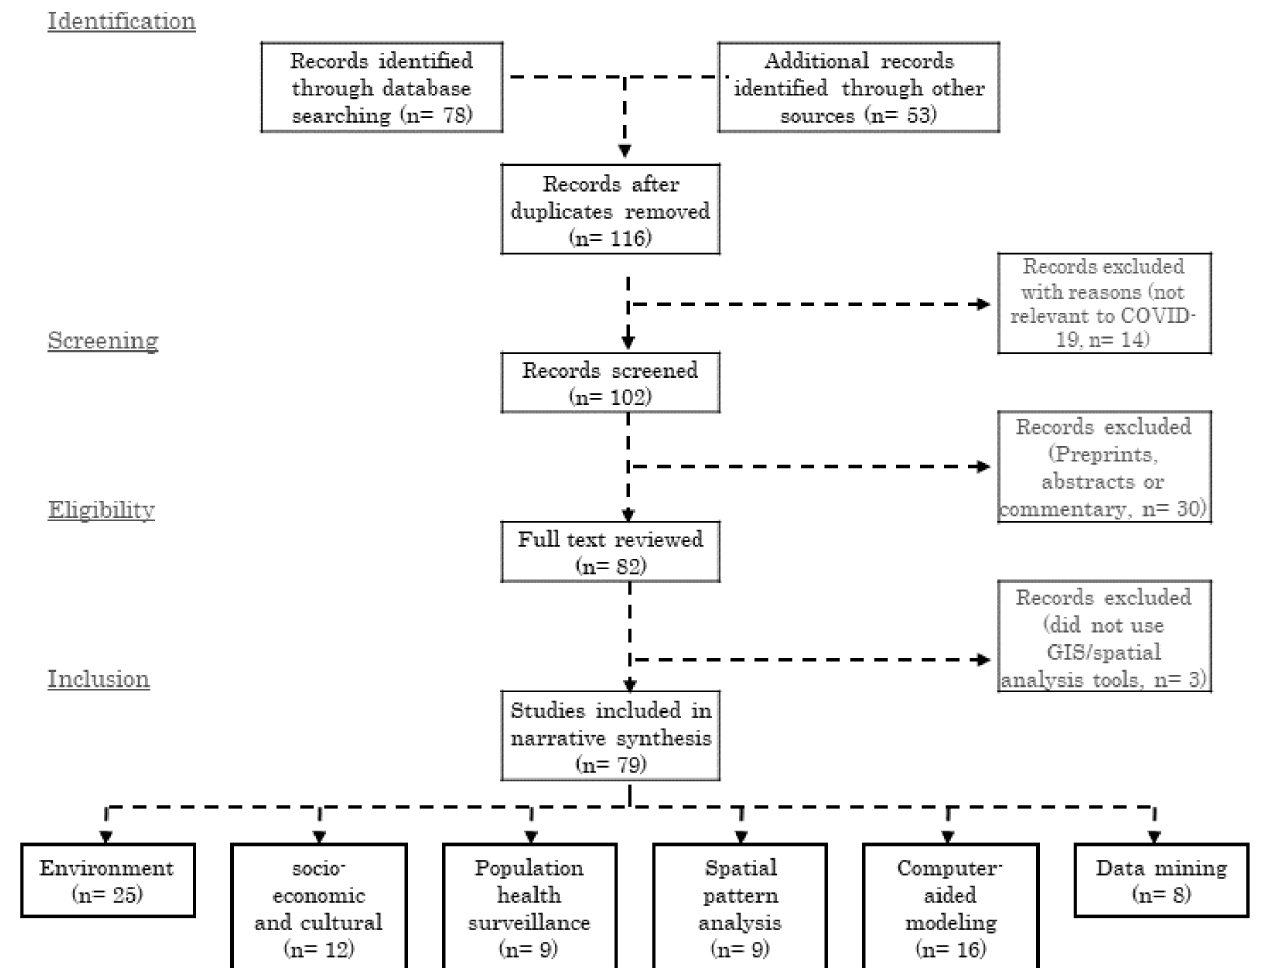
Figure 1. GIS Applications in COVID-19 research literature search and evaluation for